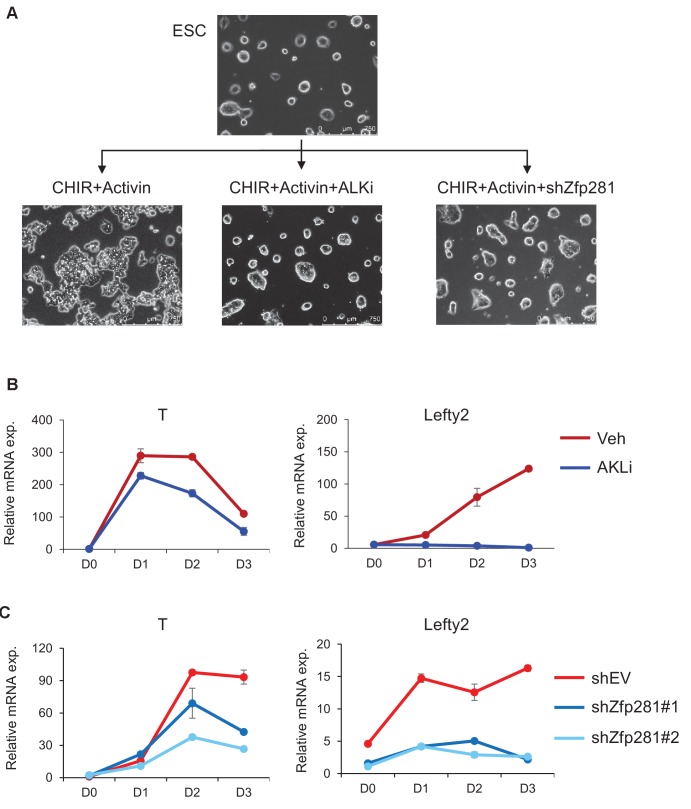
Zfp281 is required for ESCs differentiating to primitive streak (PS)-like cells.(A) Phase images of ESCs and PS-like like cells with control, ALK inhibitor (ALKi) or Zfp281 shRNA treatments. (B) RT-qPCR for expression of T and Lefty2 at different days in ESC-to-PS-like cells differentiation with vehicle or ALKi treatment. (C) RT-qPCR for expression of T and Lefty2 at different days in ESC-to-PS-like cells differentiation with empty vector or Zfp281 shRNA treatment.